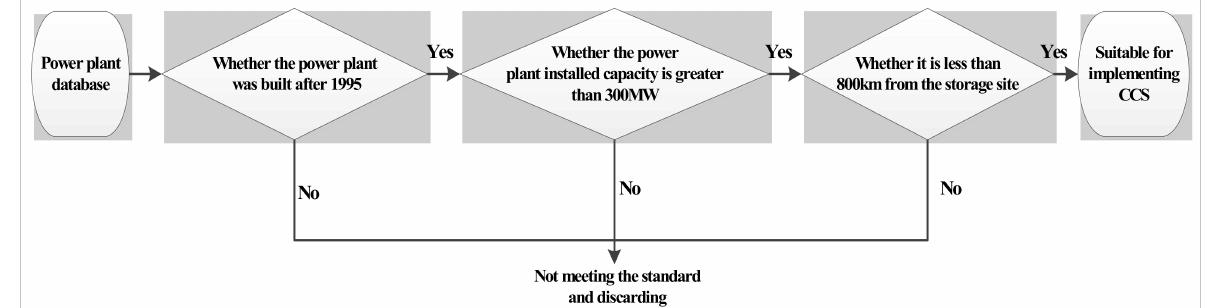
Figure 1. The screening process of available plants for CCS implementation.